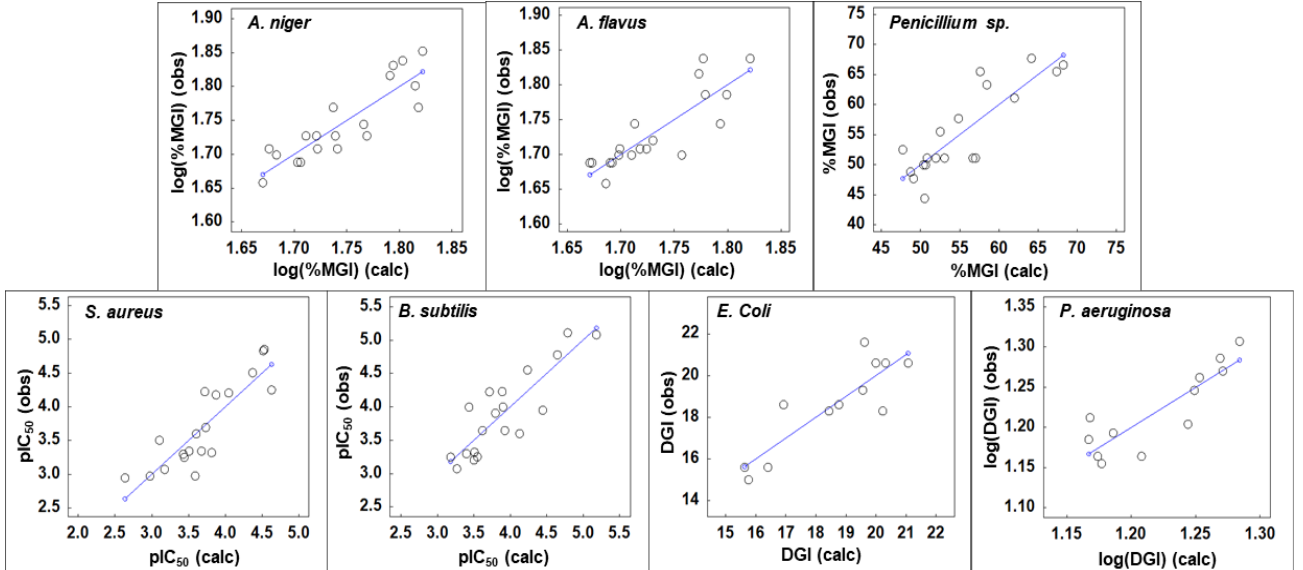
Figure 2. Observed vs. predicted plots of antifungal and antibiotic activities for triazolothiadiazines against Aspergillus niger, Aspergillus flavus, Penicillium sp., and Staphylococcus aureus , Bacillus subtilis , Escherichia coli and Pseudomonas aeruginosa . Several validated quantitative structure activity relationship (QSAR) equations were developed to describe the antifungal and antibiotic activities of triazolothiadiazines, and the best equations and their topological descriptors are given in Table 3. QSAR models X1 , X2 , X3 , X4 , and X5 for Aspergillus niger , Aspergillus flavus , Penicillium sp . , Staphylococcus aureus, and Bacillus subtilis have 19 compounds in the training set and were developed with 3 descriptors . QSAR models X6 and X7 for Escherichia coli and Pseudomonas aeruginosa were developed with a training set with 12 compounds with 2 descriptors. Seven compounds did not have activities against Escherichia coli and Pseudomonas aeruginosa and are not included in the models. The QSAR equations in Table 3 provided the best leave one out cross-validation criteria ( Q 2LOO ) and are free of outliers. The QSAR equations in Table 3 have R 2 values between 0.725 and 0.768 and possess suitable internal validation Q 2 LOO values 0.602 to 0.622 for models X1 , X2 , X3 , X4 , X5 , and X6 . Models X7 has a Q 2 LOO of Table 3. Quantitative structure – activity relationship models of triazolothiadiazine compounds for antifungal and antibiotic activities.